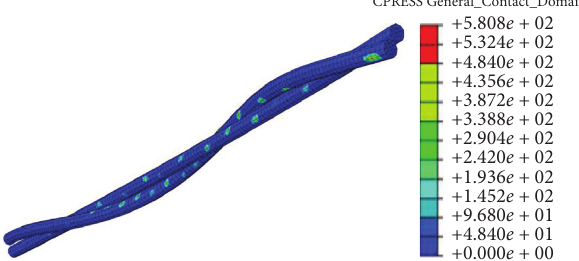
Figure 14: Contact stress between core wire and side wire of wire rope.